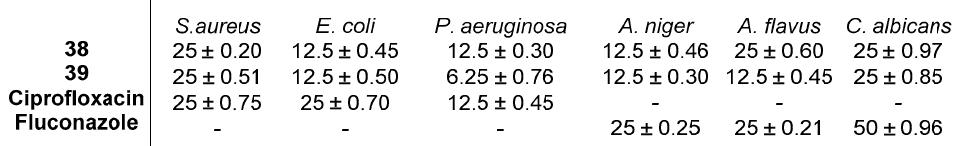
Figure 15. Chemical structure and minimal inhibitory concentration (MIC) values of antibacterial coumarins proposed by Nagamallu and colleagues [79].